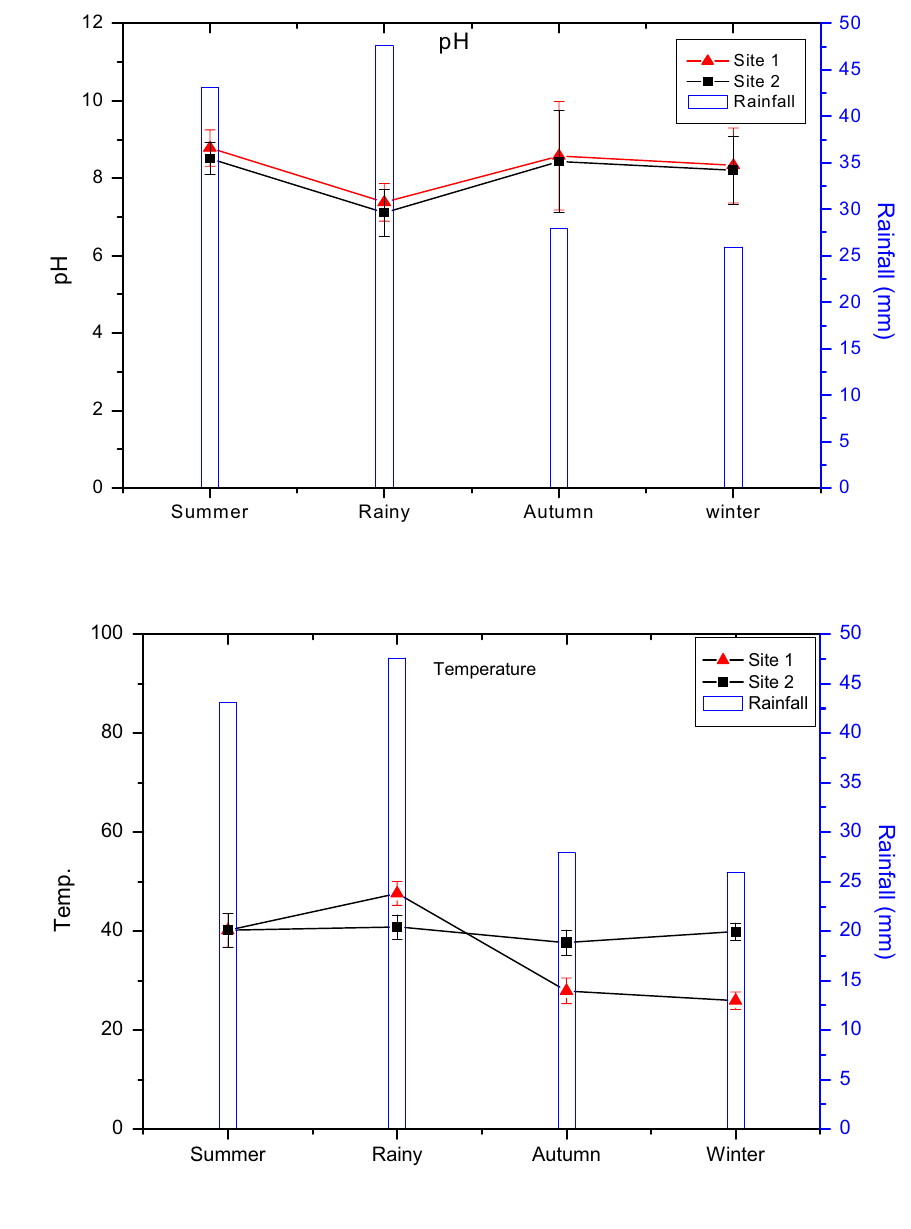
Fig. 2 Average seasonal varia- tions of pH at different seasons of Site 1 and Site 2 Ludhiana,